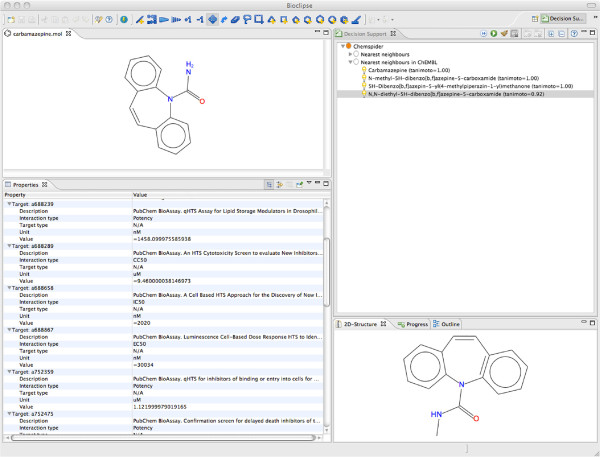
Screenshot from the Bioclipse Decision Support with results from a combined ChemSpider and ChEMBL-RDF search. The top left canvas contains the query structure, carbamezapine, and the top right canvas shows its near neighbors found in ChemSpider for which ChEMBL-RDF data exists. The lower right canvas shows the chemical structure selected in the top right canvas, and the lower left canvas shows the available activities in ChEMBL-RDF for this compound.